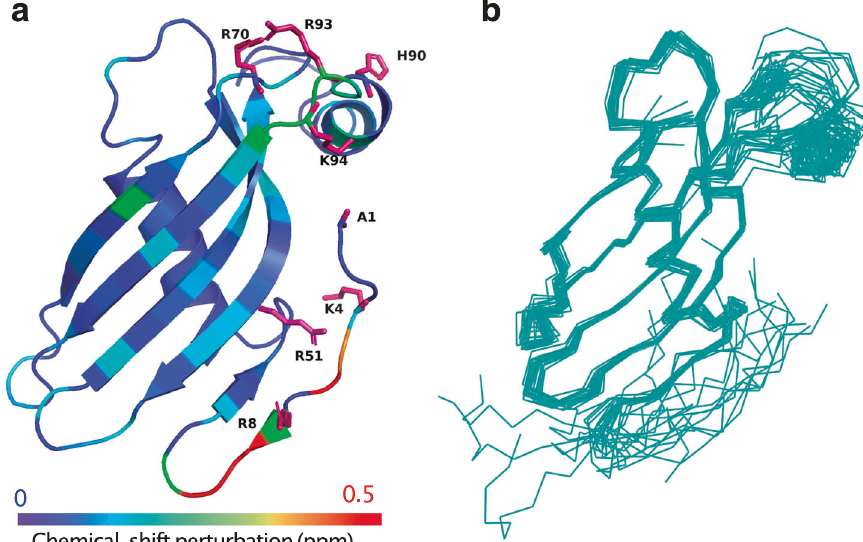
Fig. 6 HS binds to positive charges in the two most fl exible regions of Cst-3: the N-terminus and a region around H90. a Cst-3 ribbon was colored based on NMR chemical shift perturbation (CSP) upon HS oligosaccharide titration. Positively charged residues in the N-terminus and near H90 are shown in pink stick model, including A1 (with charged N-terminus amino group), K4, R8, R51, R70, H90, R93, and K94. This structure was generated from homology modeling of model 2 of the NMR structure of human Cst-3 (PDB:6RPV). b NMR structure ensemble of the full-length monomeric human Cst-3 (PDB:6RPV), demonstrating the fl exibility of the N-terminus and the region around H90.